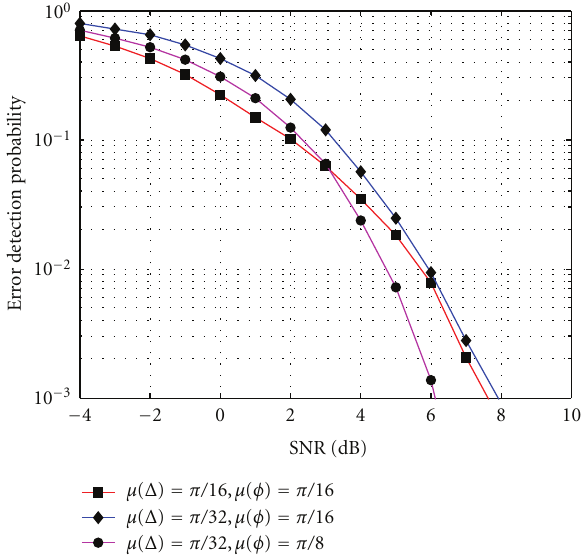
Figure 17: Error detection probability as a function of elementary